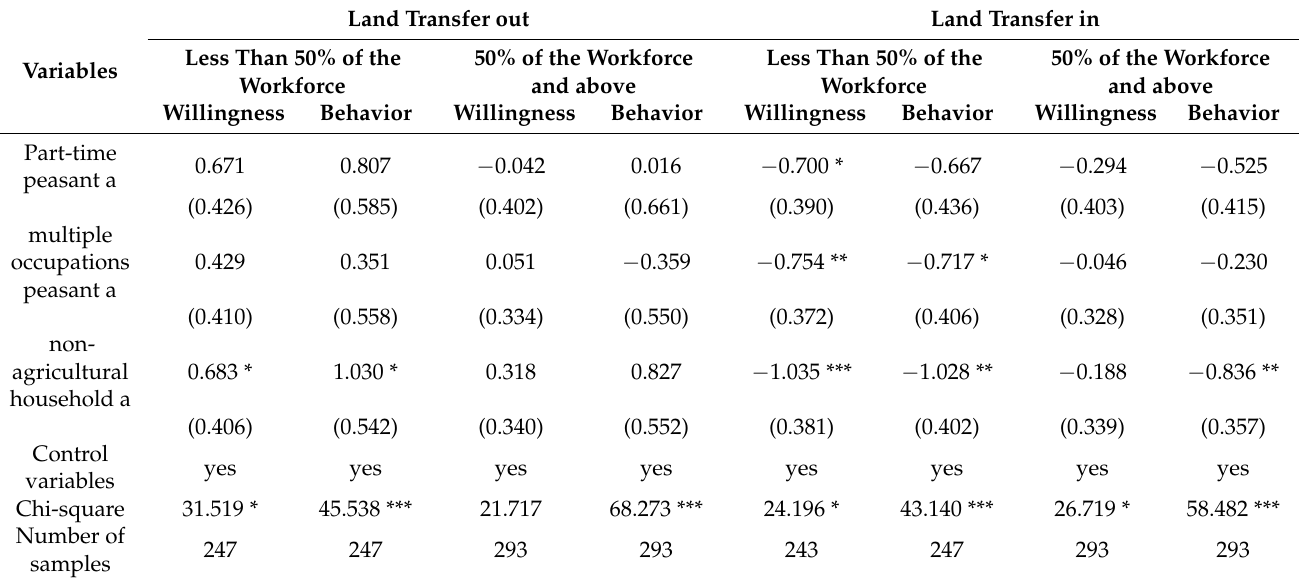
Table 8. Regression results of land transfer intention and behavior of different labor forces in the total household